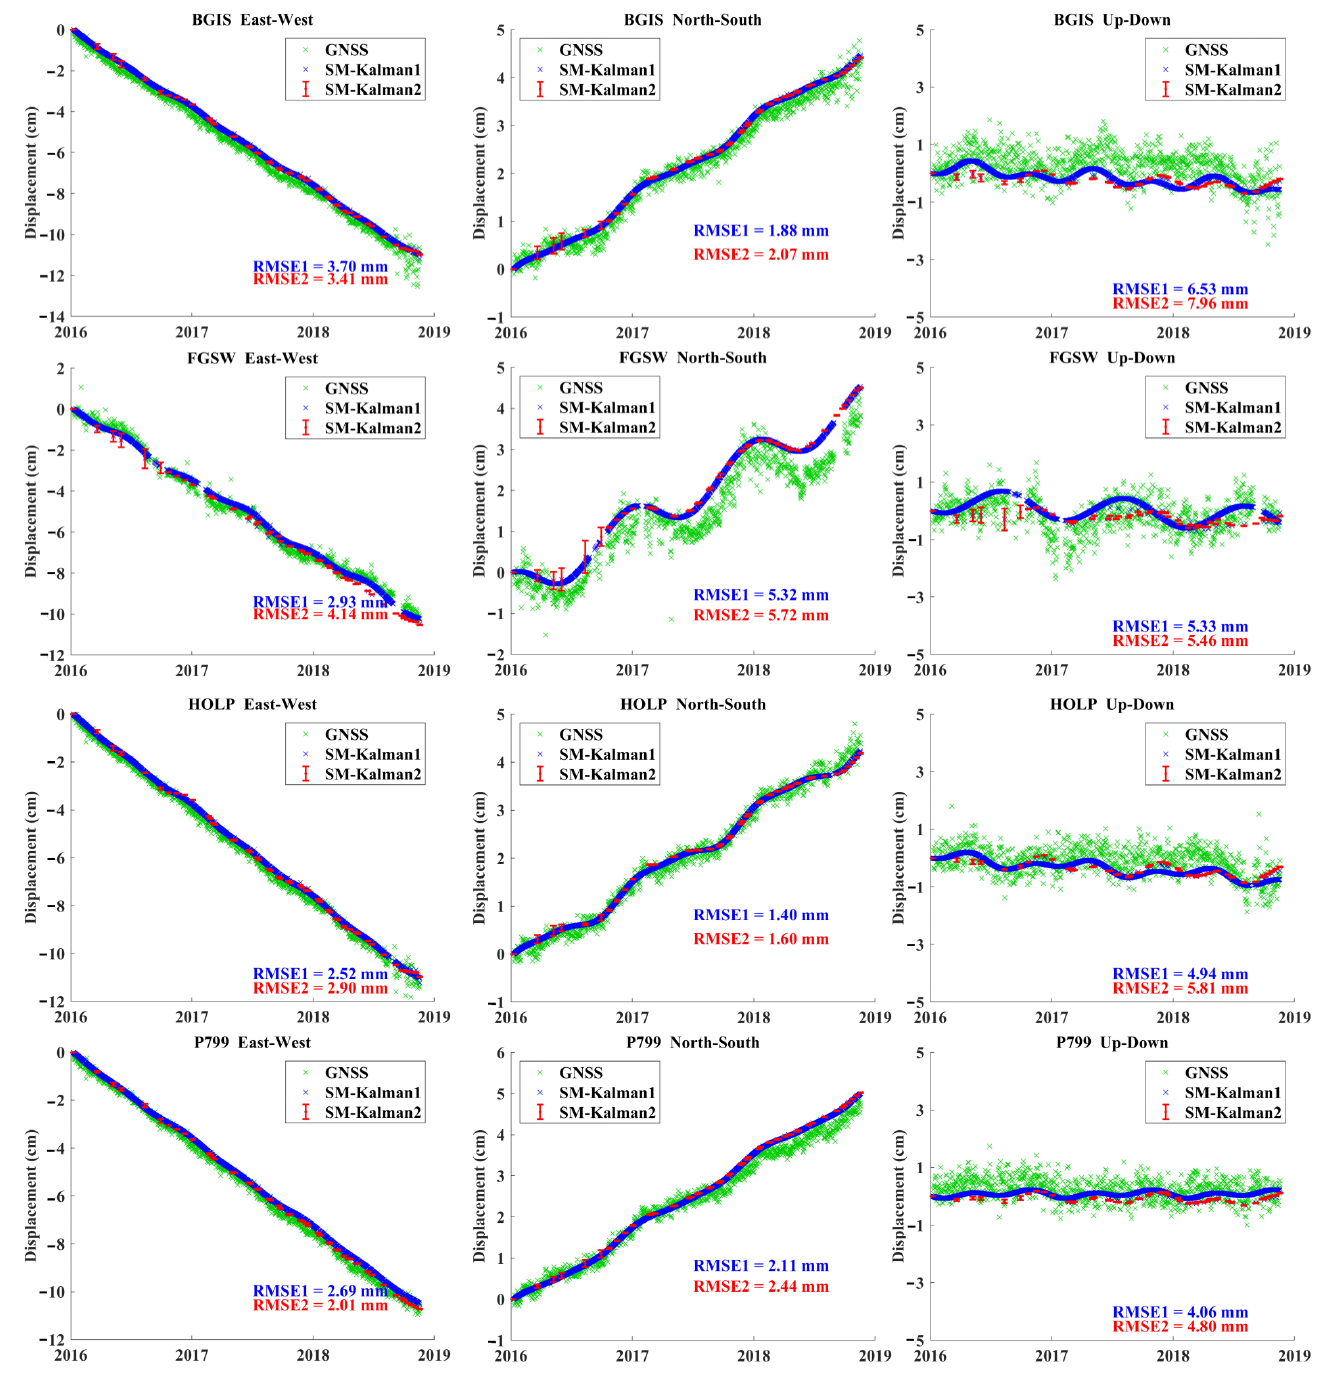
Figure 12. Comparison of GNSS results and deformation time series provided by SM-Kalman at two different temporal